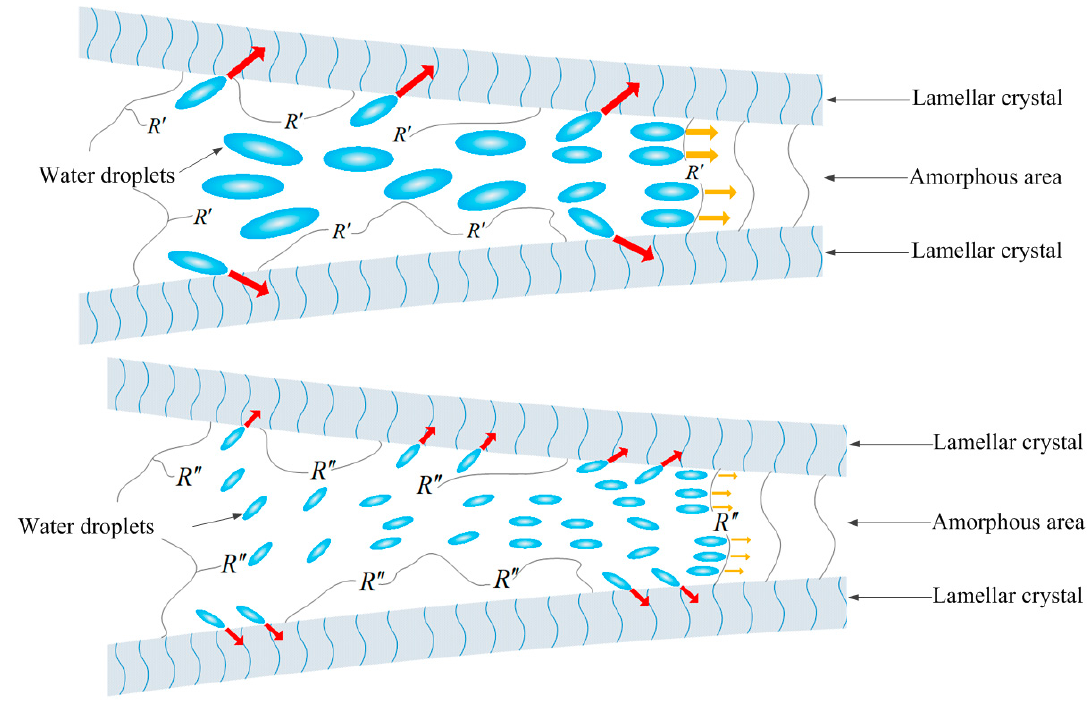
Figure 7. Schematic electromechanical mechanism of water microbeads diffusion and breaking through the amorphous areas in XLPE-HAV2 (top panel) and XLPE-TMPTMA or XLPE-TAIC (bottom panel).